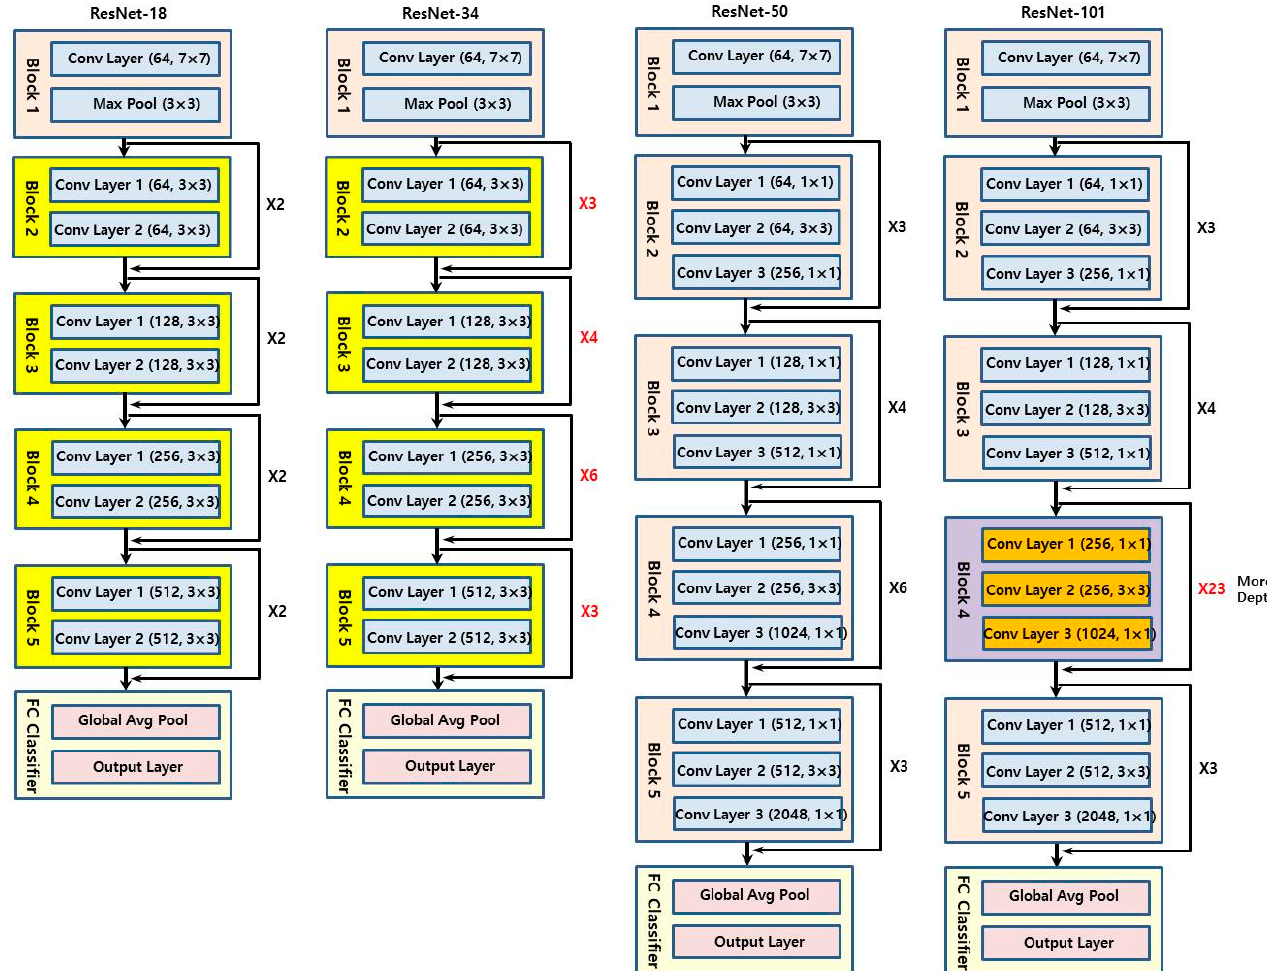
Figure 2. Schematic diagrams of the deep learning models used in this study: ResNet-18, ResNet-34, ResNet-50, ResNet-101.